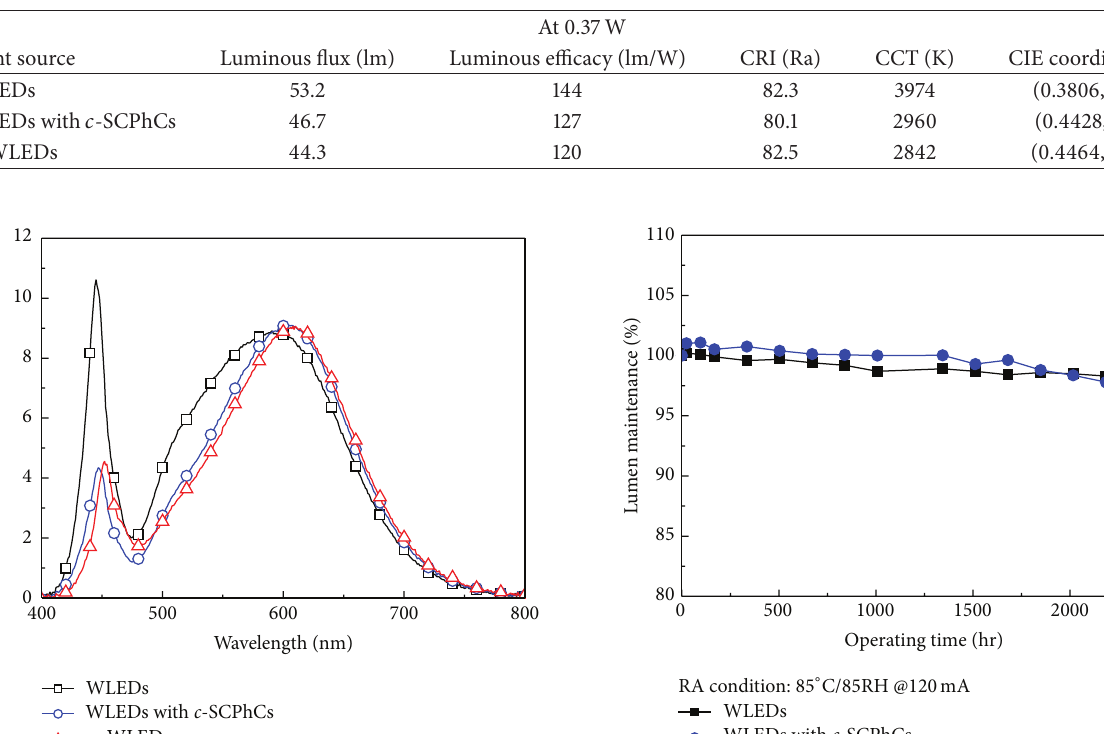
Table 1: Optical characteristics of all light sources.